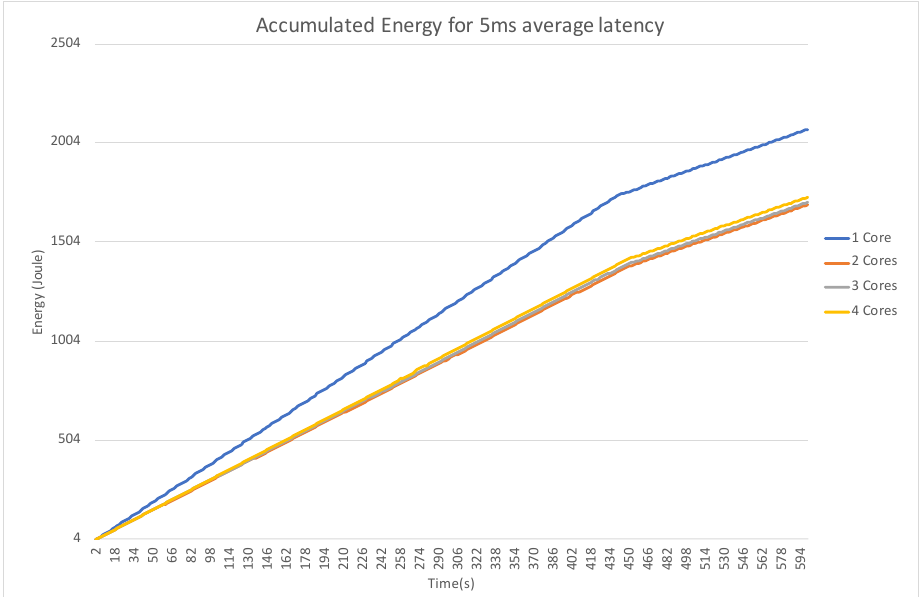
Figure 15. Accumulated energy consumption for different number of cores during network average latency test with 5 ms